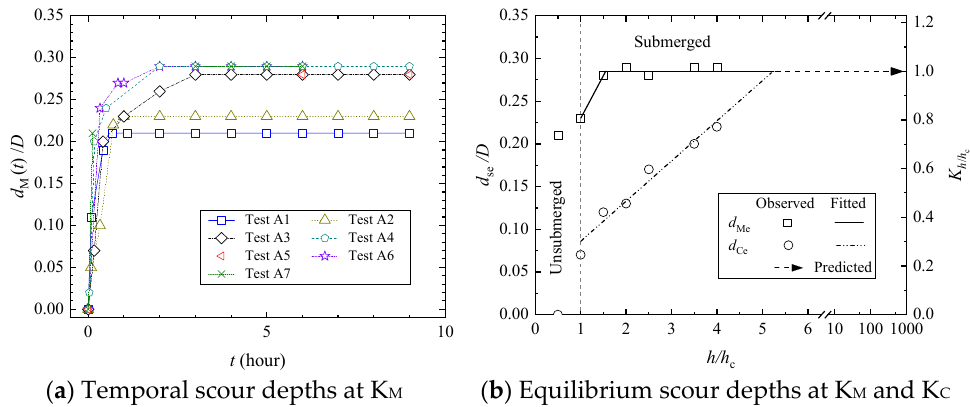
( ) d is the scour depth at scouring time t at K M , ( t ) is the scour depth at scouring time t at K M M is the submergence factor on equilibrium scour c